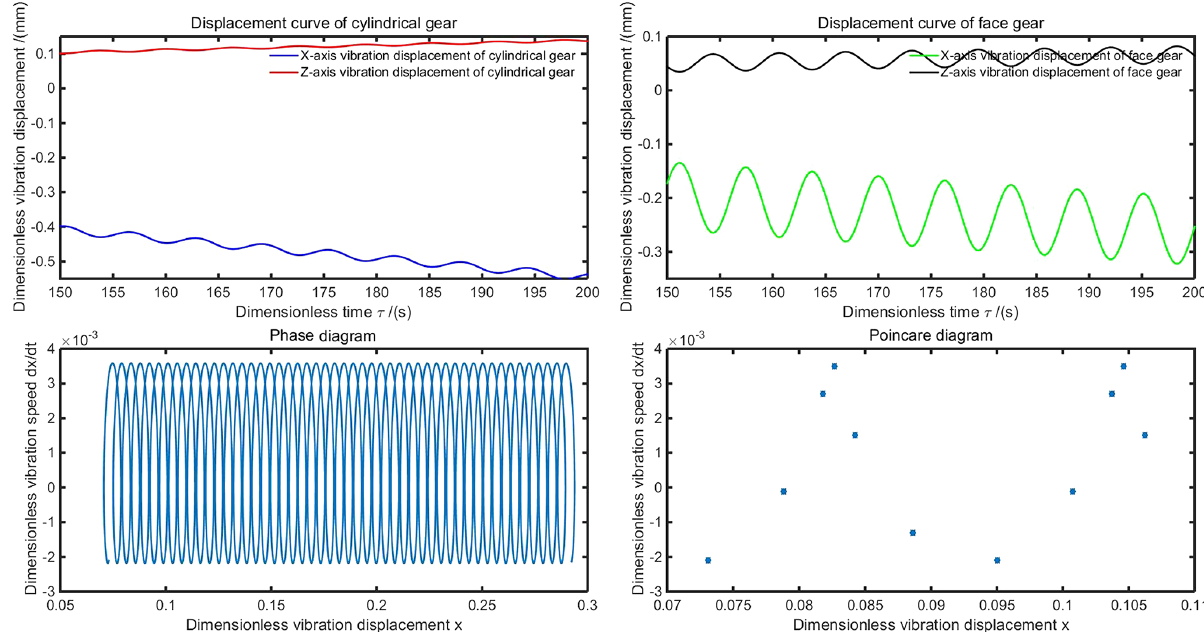
Figure 7. Displacement, phase, and Poincare diagrams of friction coefficient 0.1.